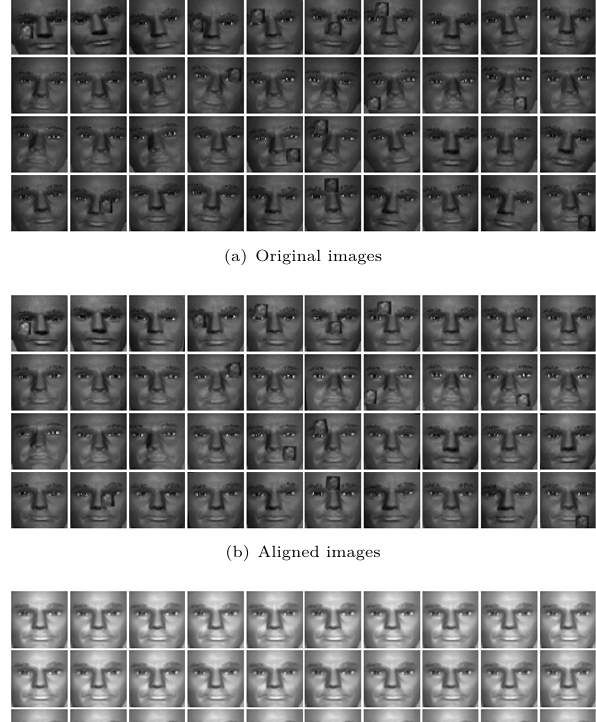
Algorithm 2 Alternative sparsity pursuit (inner loop)